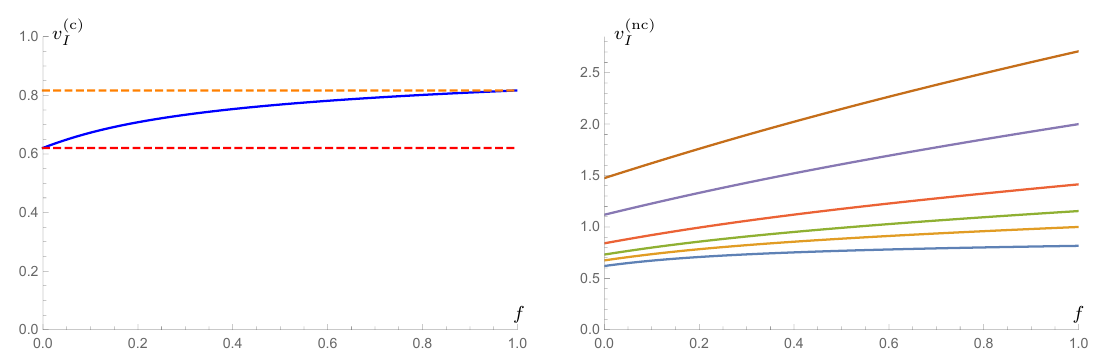
( f = 0) = v (c) and v (c) ( f = 1) = v (c) , depicted in red I E I B